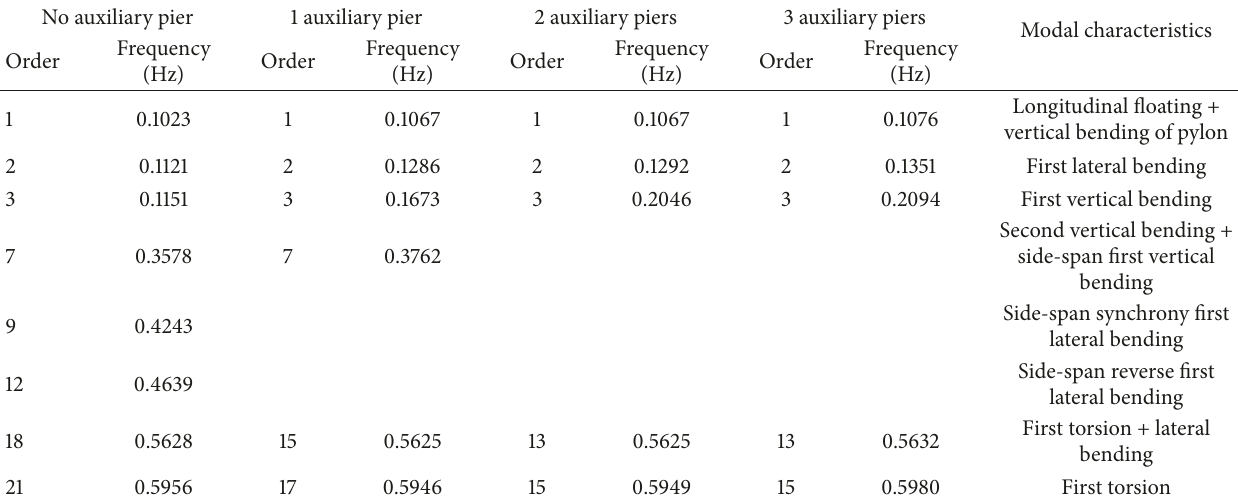
Table 7: Dynamic characteristics of CFRP cable-stayed bridge with different numbers of auxiliary